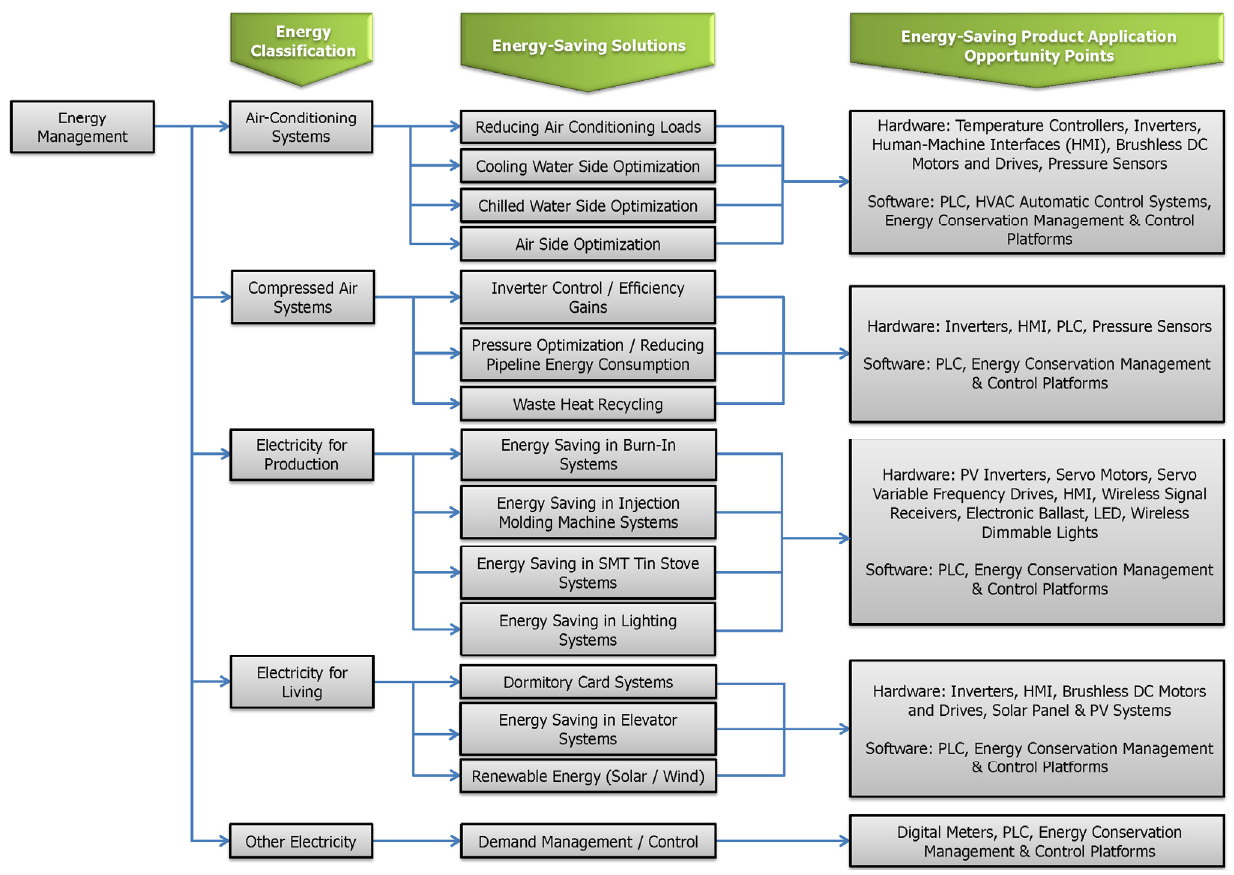
Figure 4. Energy-use types and energy-saving